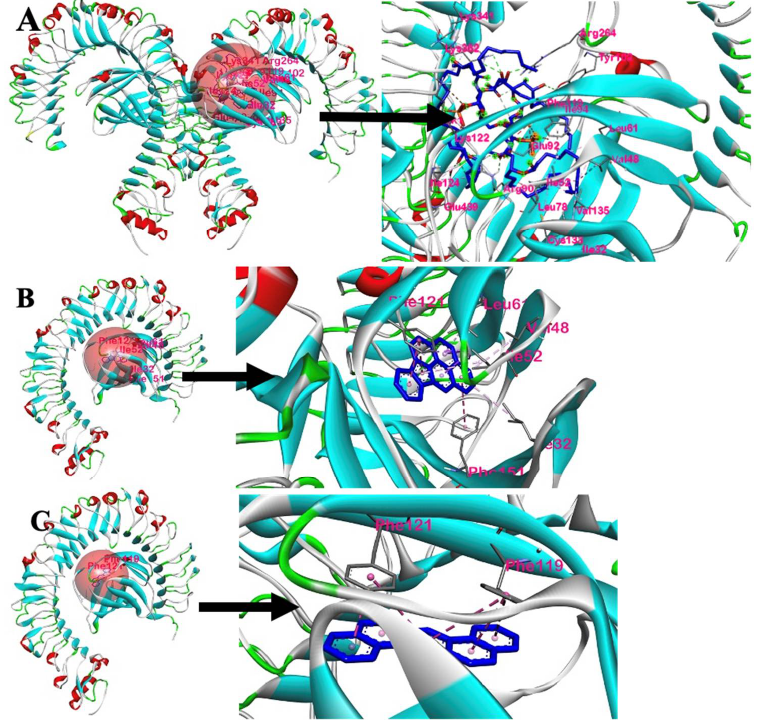
Figure 7. Receptor–ligand interactions: ( A ) LPS with TLR4, ( B ) Indeno(1,2,3-cd)pyrene with TLR4, and ( C ) Dibenz(a,h)anthracene with TLR4.